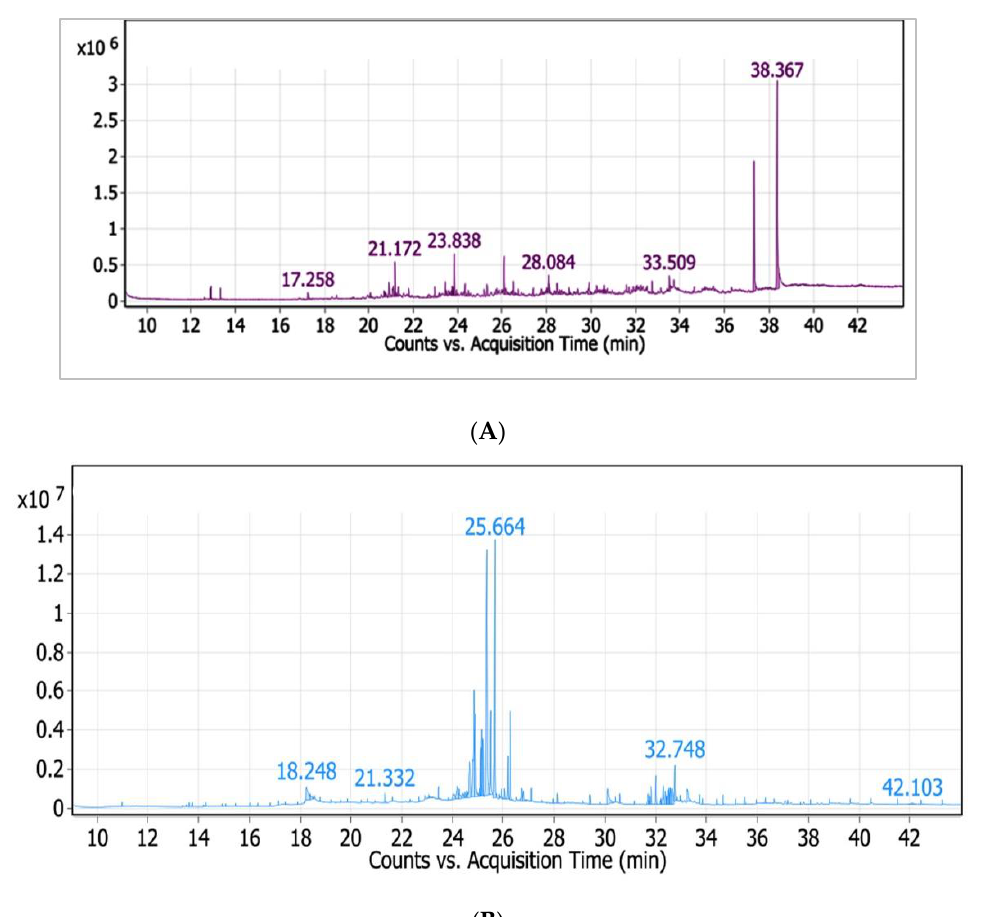
Figure 2. ( A ). GC-MS spectral chromatogram of Z. spina-christi leaves extract; ( B ). GC-MS spectral chromatogram of Z. spina-christi fruits extract.